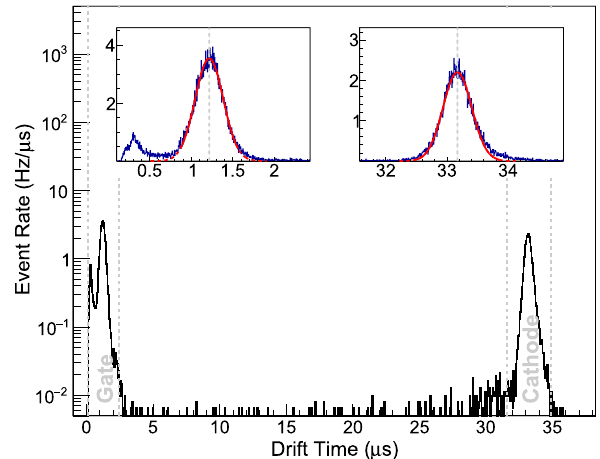
Fig. 19 Drift time distribution of small-sized S2 events for 222 Rn data in the TPC for a field of 225V/cm zooming into the gate region (left inset) and the cathode region (right inset)